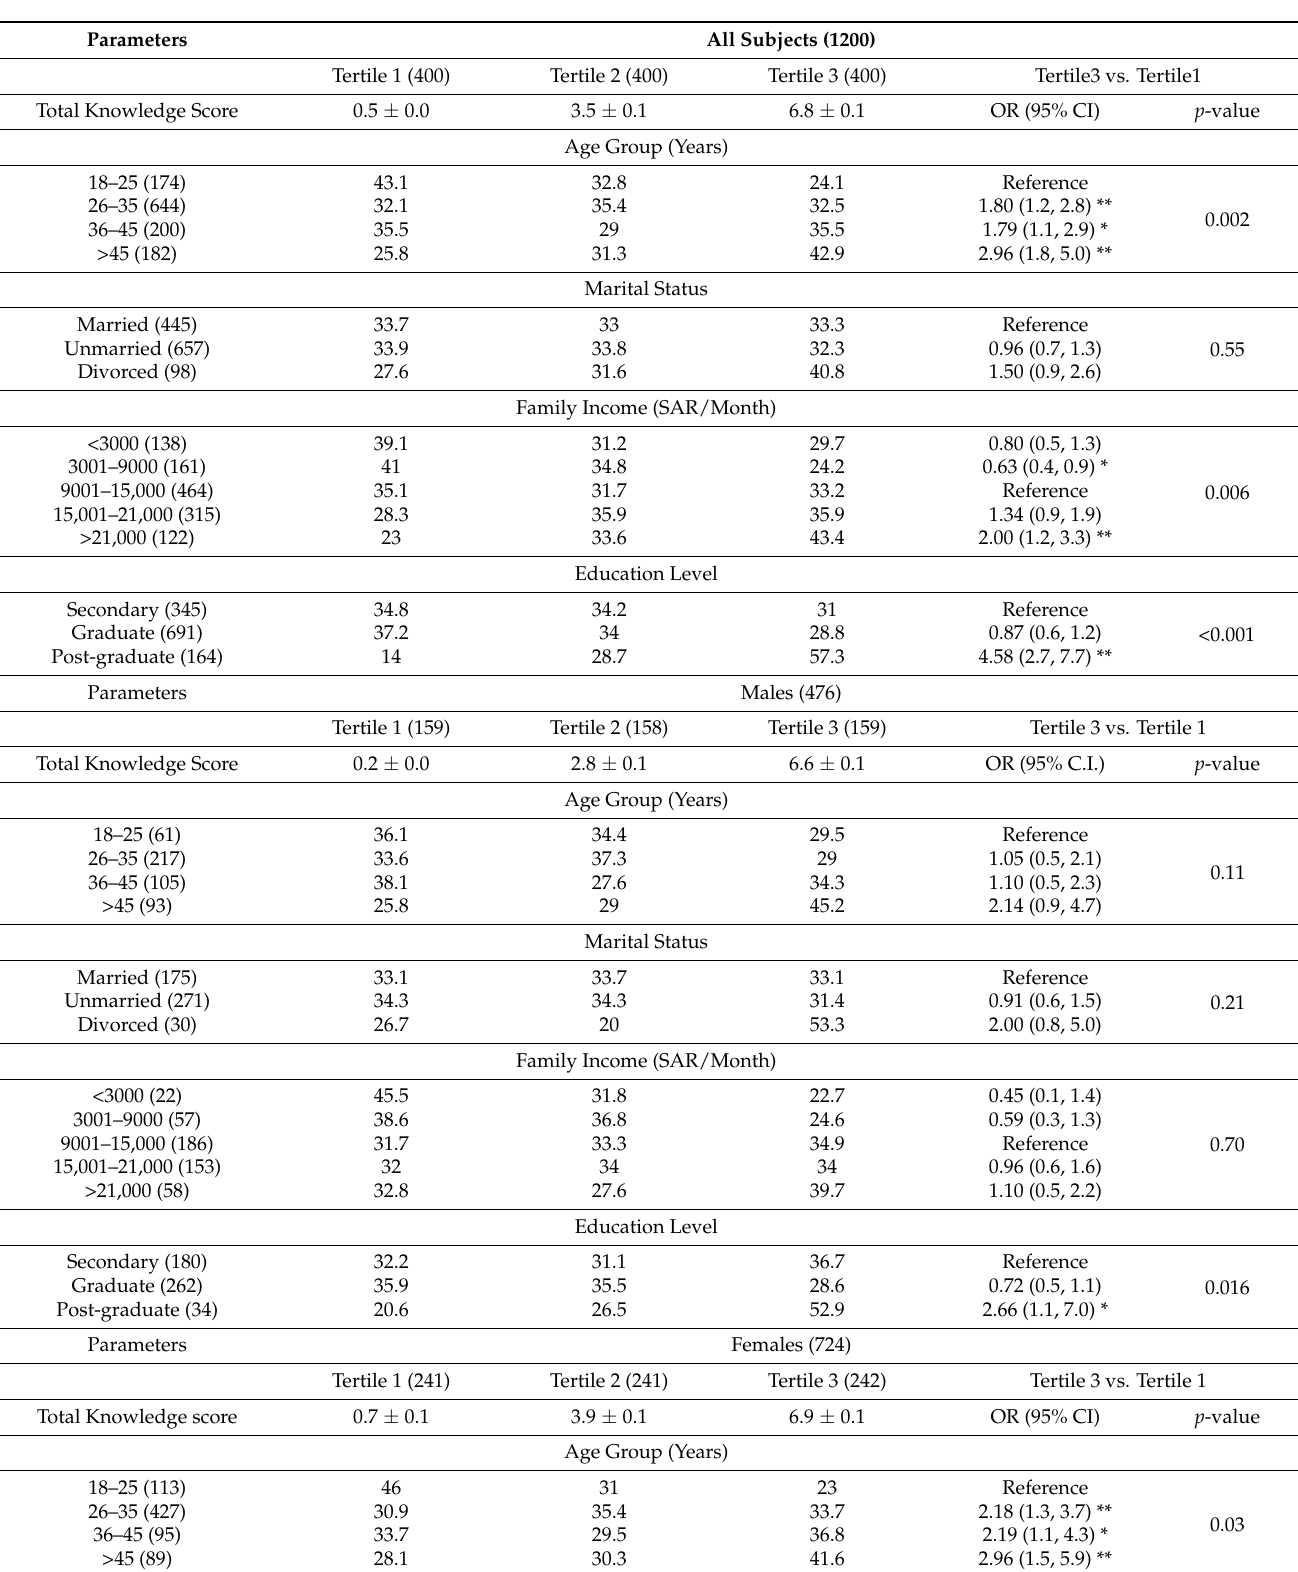
Table 3. Knowledge scores according to socio-demographic